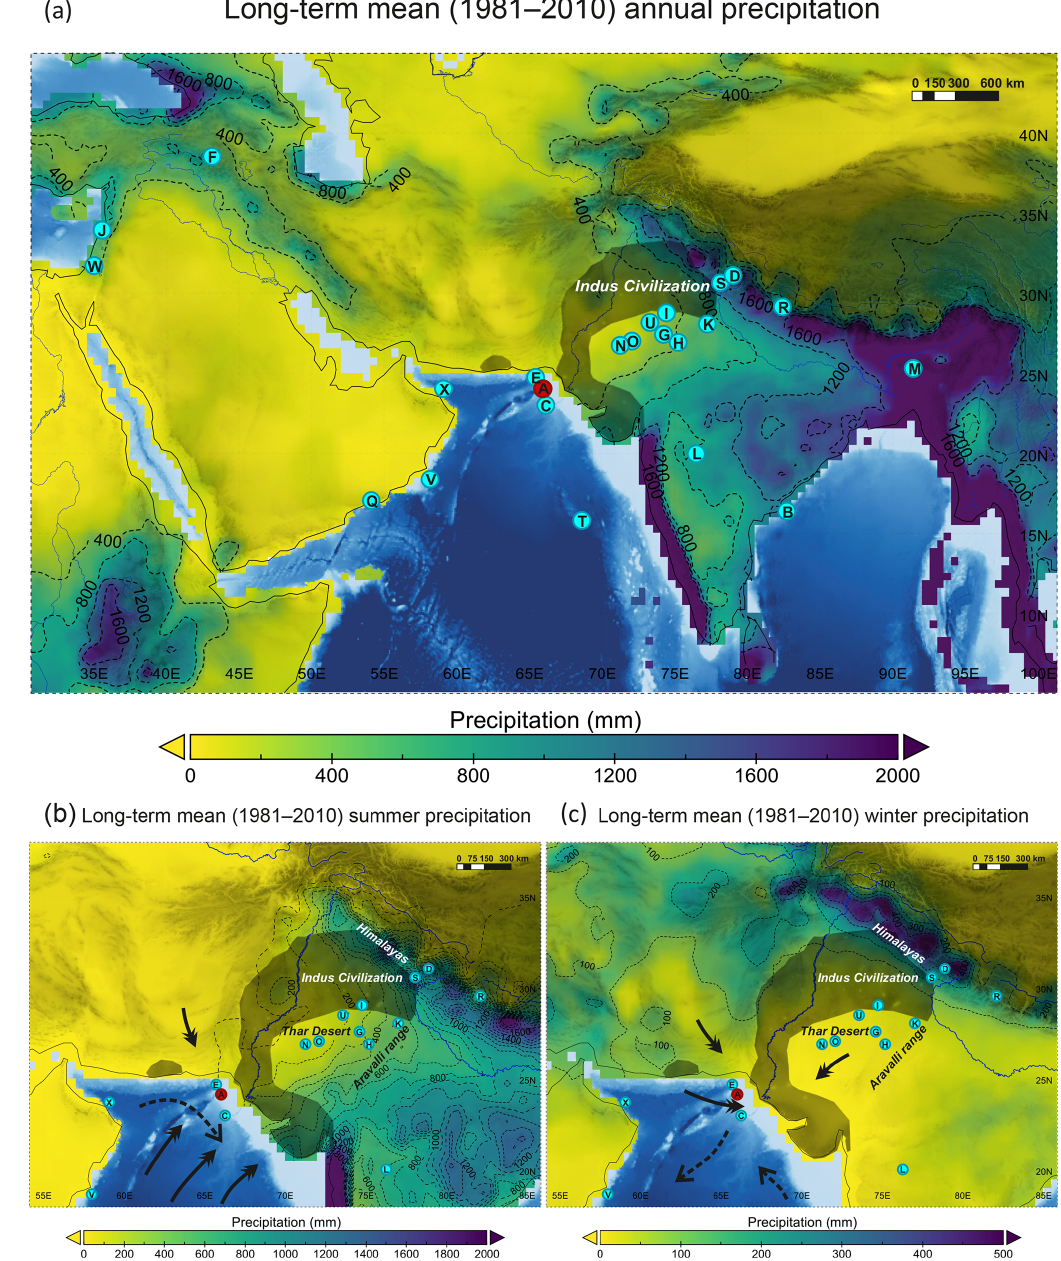
Figure 1. (a) Annual, (b) ISM (JJAS), and (c) IWM (DJFM) mean precipitation (1981–2010) isohyets taken from the GPCC V7 global gridded dataset (0 . 5 ◦ × 0 . 5 ◦ resolution) (Schneider et al., 2015); note the difference in scale for summer and winter precipitation (0–2000mm vs. 0–500mm). Rainfall data overlain on GEBCO 2014 ocean bathymetry dataset (Weatherall et al., 2015), and shaded region shows extent of the Indus Civilization. Bold arrows show main wind directions, dashed arrows show ocean surface currents. Other studies discussed